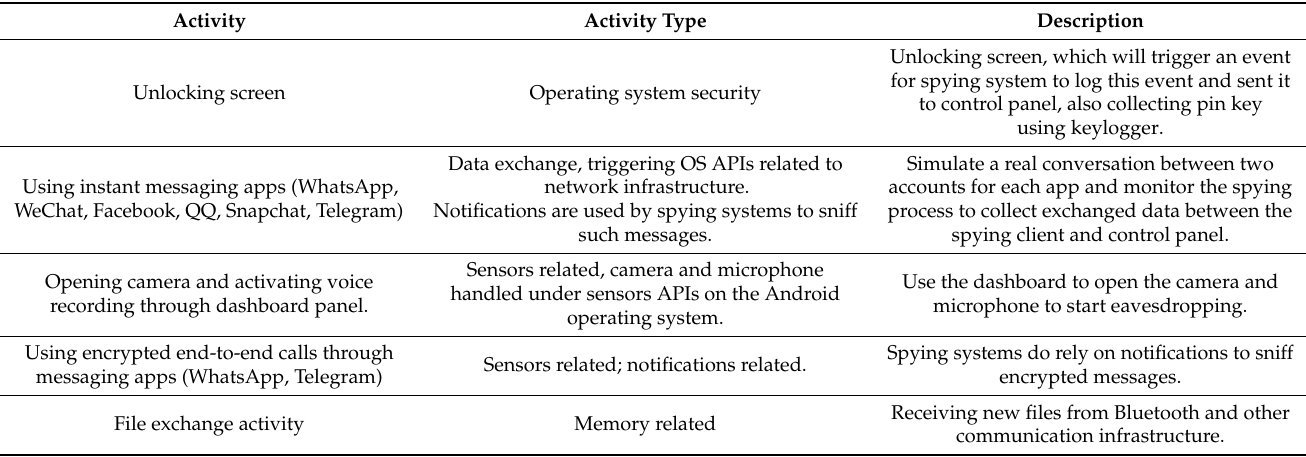
Table 7. Activity list adopted during data